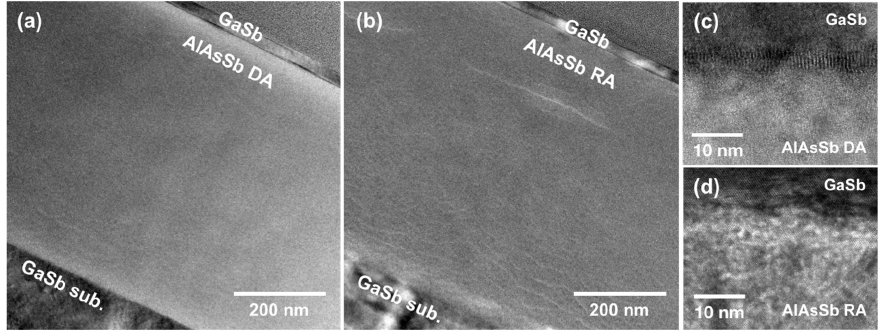
Figure 2. Cross-section TEM images for the AlAsSb ( a ) DA and ( b ) RA samples, and ( c , d ) show the HRTEM images of the GaSb/AlAsSb interfaces.